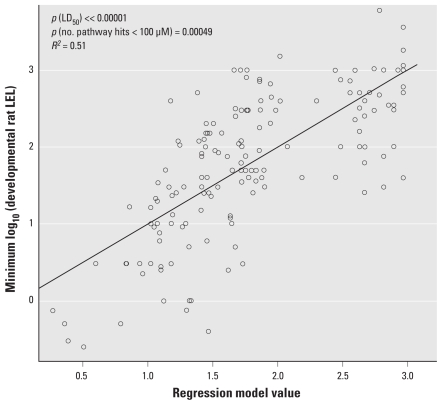
Association between the number of minimal pathway hits (which we assume is inversely correlated with the minimum concentration at which significant pathway activity occurs for the chemical) and the lowest dose in vivo at which a significant toxicity end point is observed, in this case for the rat prenatal developmental bioassay. Each point represents a single chemical. The x-axis is the value resulting from the fitted model, which is 0.6 + 0.4 × log10(LD50) – 0.037 × (number of minimal pathway hits at concentrations < 30 μM). The y-axis is the minimum log10(concentration) at which toxicity is seen for this study type. This analysis was performed on the 153 chemicals for which we had all values.